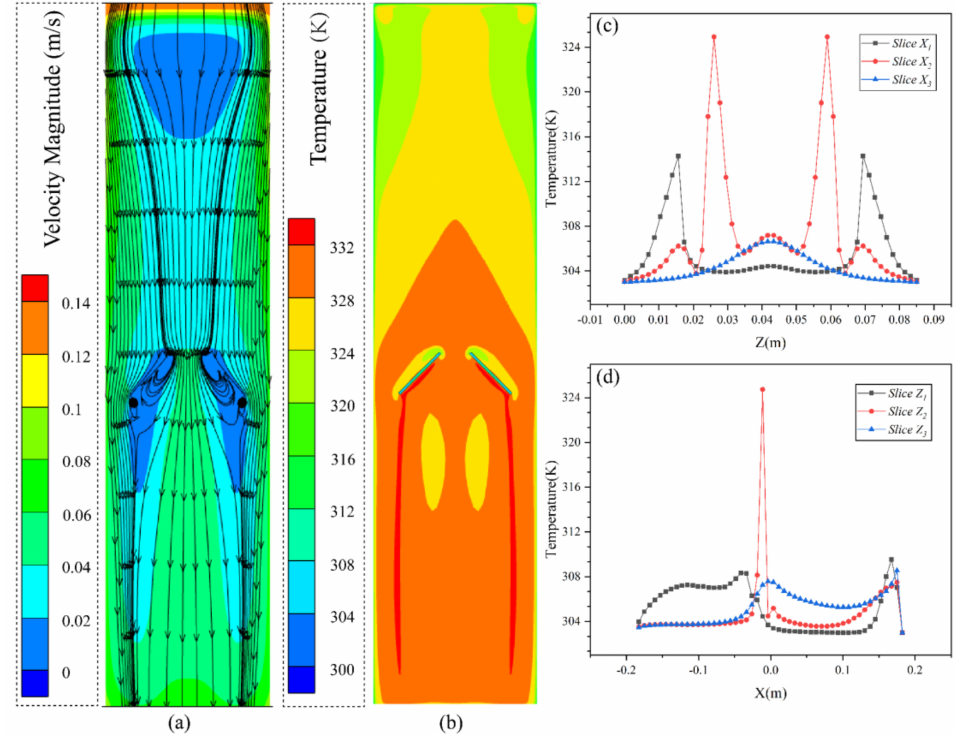
Figure 6. Diagrams of channel with 45 ◦ attack angle vortex generator under steady state conditions: ( a ) streamline diagram, ( b ) temperature contour diagram, ( c ) slice temperature diagram in X direction, ( d ) slice temperature diagram in Z